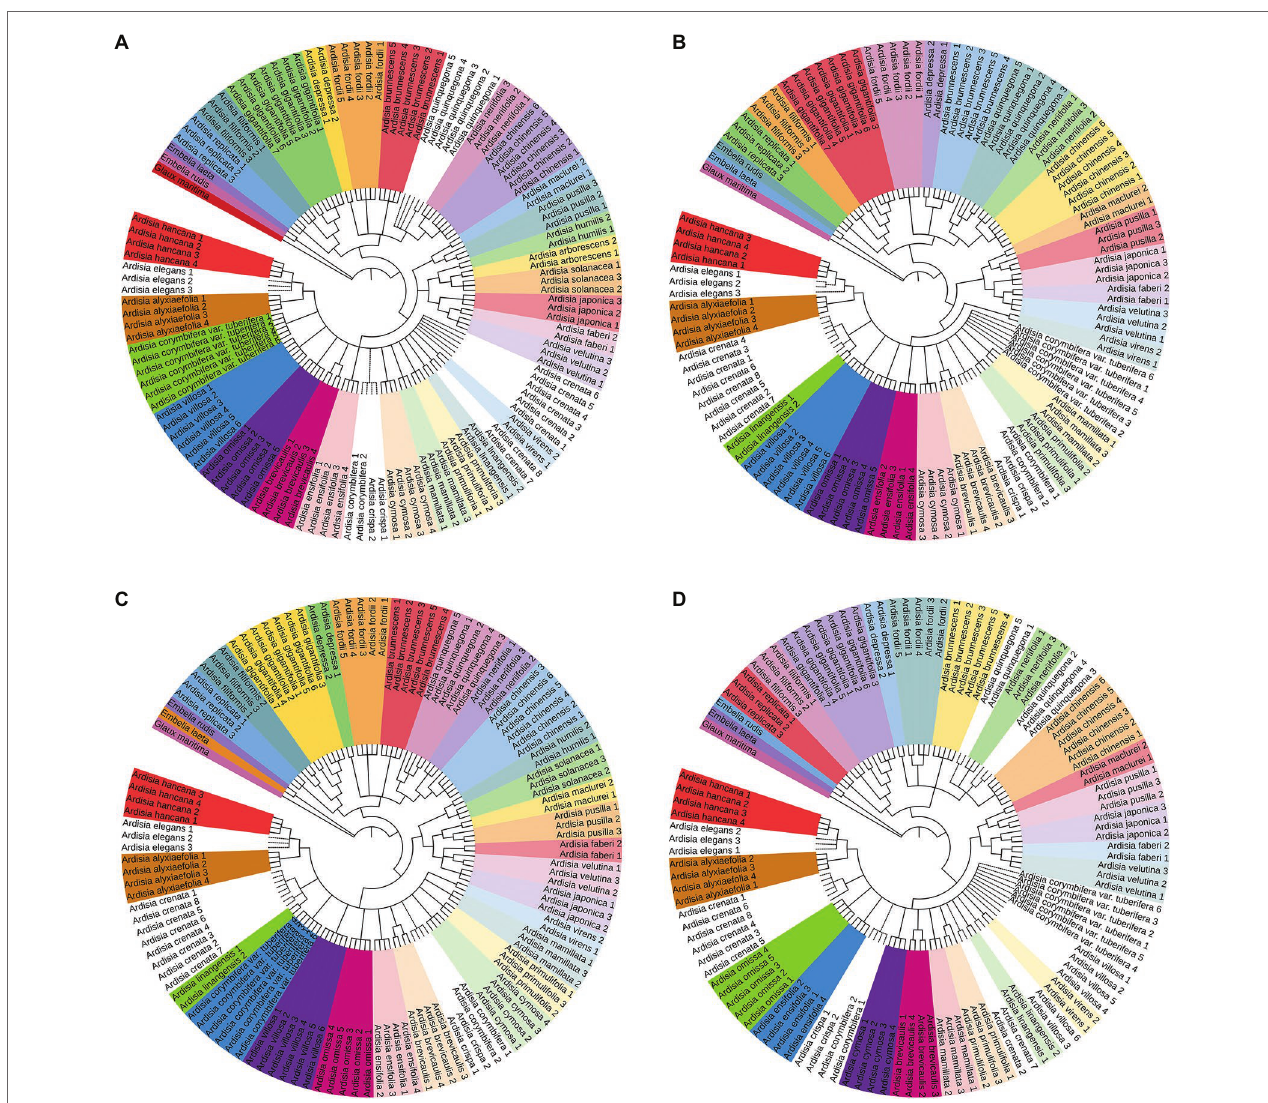
FIGURE 2 | The NJ tree based on four sequences. Successfully identified species are with bootstrap values above 60%. The dotted line indicates unsuccessful identified species. (A) The NJ tree based on ITS sequences, (B) the NJ tree based on ITS + psb A- trn H sequences, (C) the NJ tree based on ITS + mat K sequences, (D) the NJ tree based on ITS + rbc L